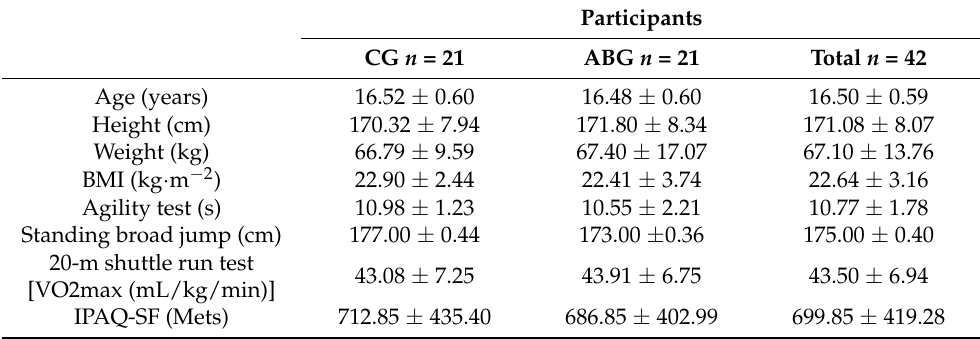
Table 1. Participants’ characteristics (mean ± SD) in the present